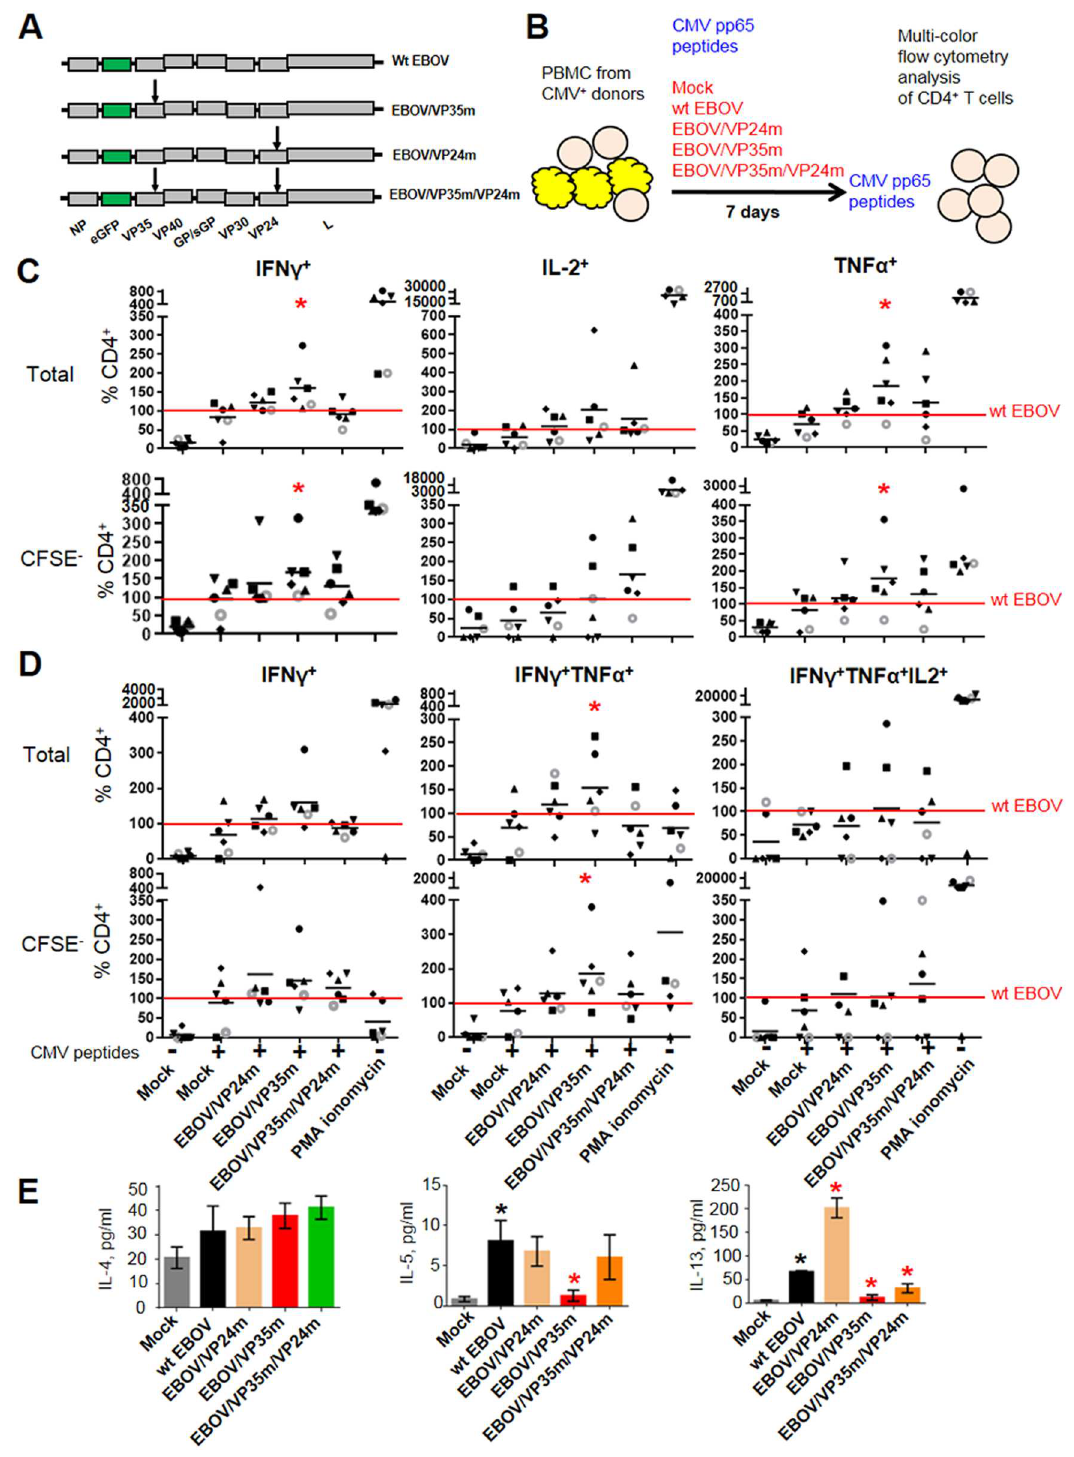
Fig 2. The VP35 IID reduces Th1 responses. A. Schematicrepresentation of the genomesof wt EBOV and mutant EBOVs used to infect cells; mutations R312Ain VP35 and K142A in VP24 are indicatedby arrows, and the inserted GFP gene is indicatedby green rectangles. B. Schematicrepresentation of the cultivationexperiment: PBMCs from CMV- positive donors were labeledwith CFSE, inoculated with the indicatedviruses at MOI of 2 PFU/cell or SEB, and stimulated with CMV pp65 peptidesfor 4 hours. PBMCs were washedand cultured for 7 days. Thereafter, cells were re-stimulated